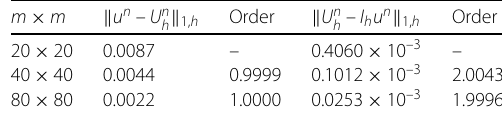
Table 1 Numerical results at t = 0.25 with τ = 5 h